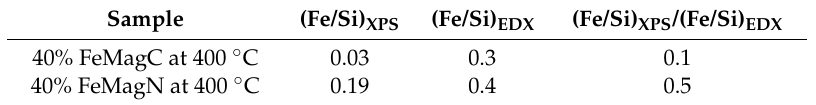
Figure 4. Deconvoluted X-ray photoelectron spectroscopy (XPS) spectra of 40% FeMagC at 400 ◦ C and 40% FeMagN at 400 ◦ C for ( A , E ) C 1 s , ( B , F ) Fe 2 p , ( C , G ) O 1 s , and ( D , H ) Si 2 p . Table 2. Fe/Si atomic ratio obtained by chemical analysis and X-ray photoelectron spectroscopy